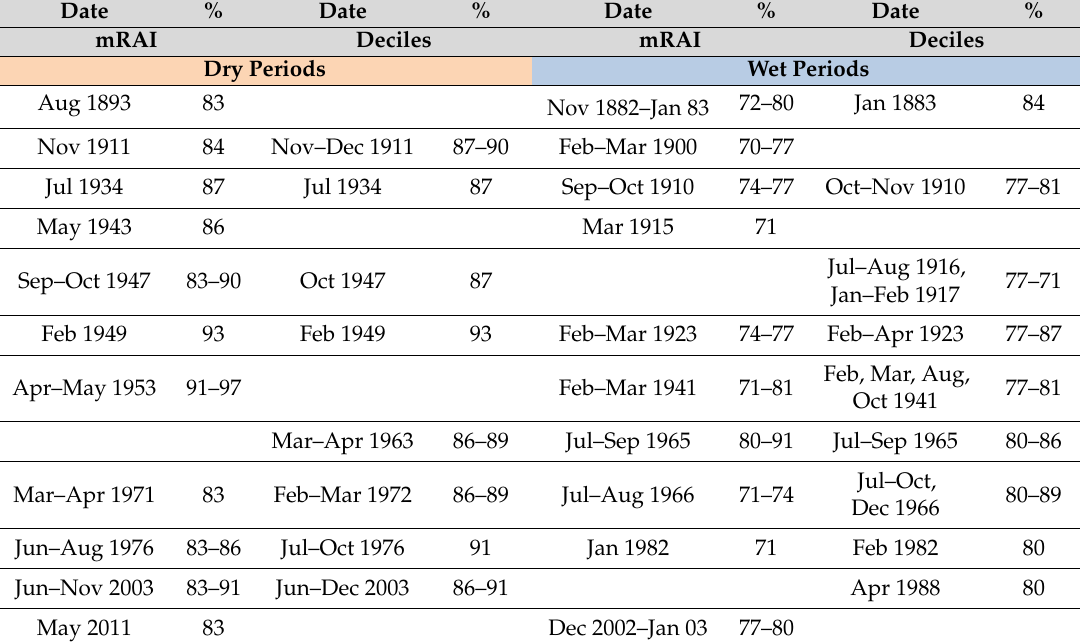
Table A4. Sub-region Central Europe—overview on the TOP20 months with the highest spatial extent of dry and wet periods within the study period